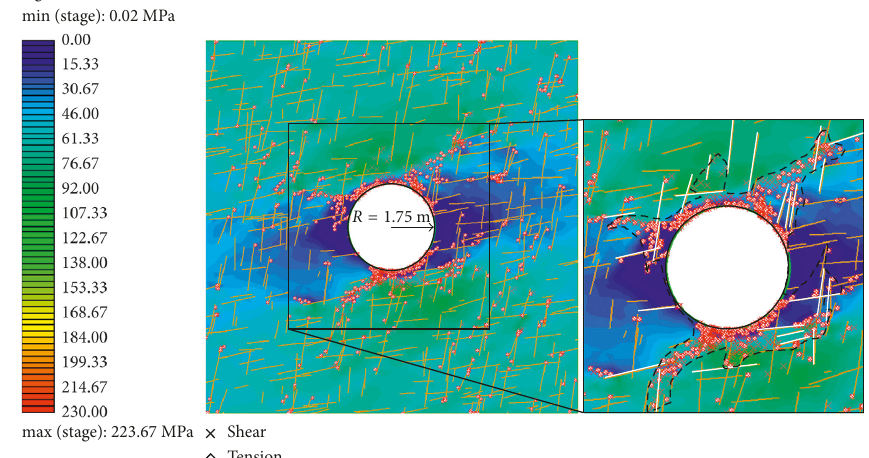
Figure 15: Major principal stress σ 1 contours of the fractured FEM model using the DISL approach [16]. Yielded elements in shear ( × ) and in tension ( ) are plotted. The dashed black line indicates the damage profile based on the recorded yielded elements. White lines indicate the contributing joints to the obtained damage ○